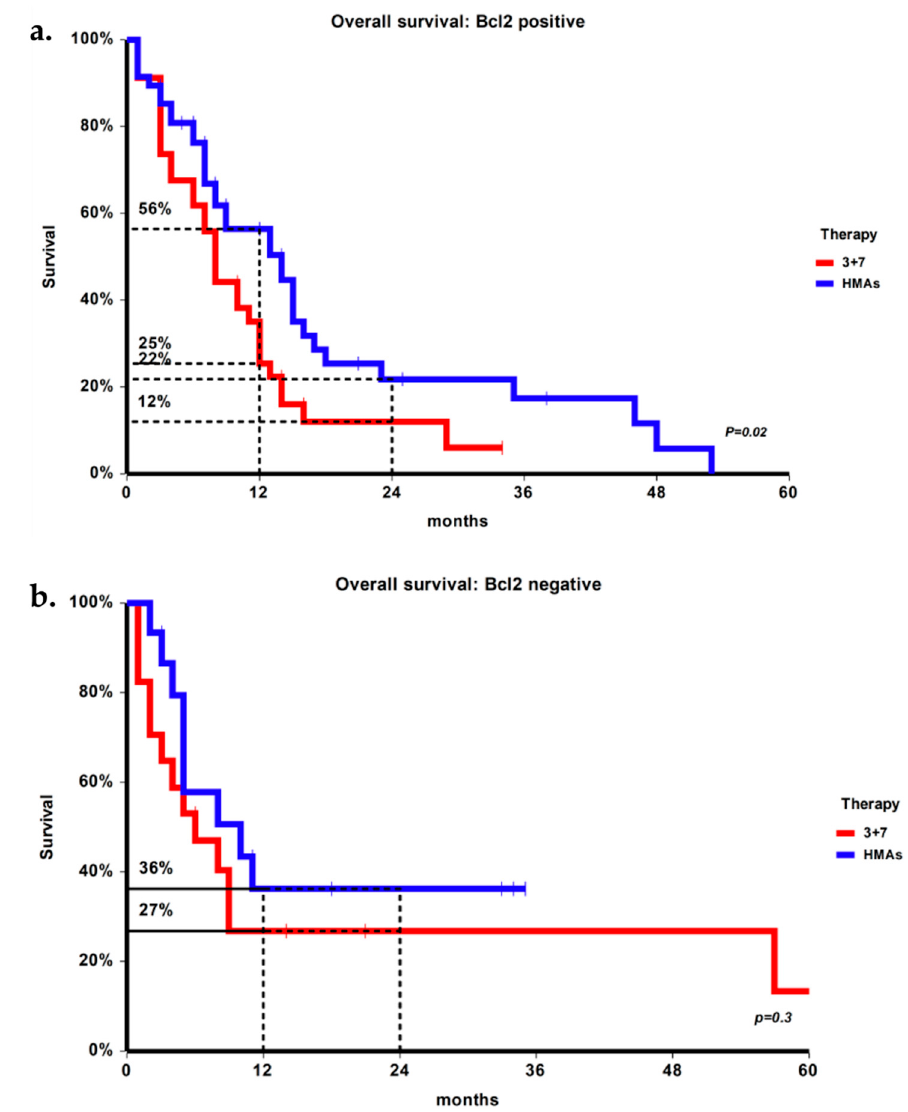
Figure 1. ( a ) Overall survival of BCL-2 positive patients according to therapy; ( b ) overall survival of BCL-2 negative patients according to therapy.